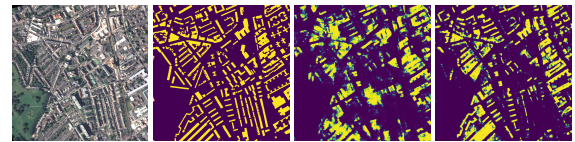
Figure 8. Advantage of stereo training for DispNetC network over an image of London (1). From left to right : image, ground truth, monocular prediction and stereo